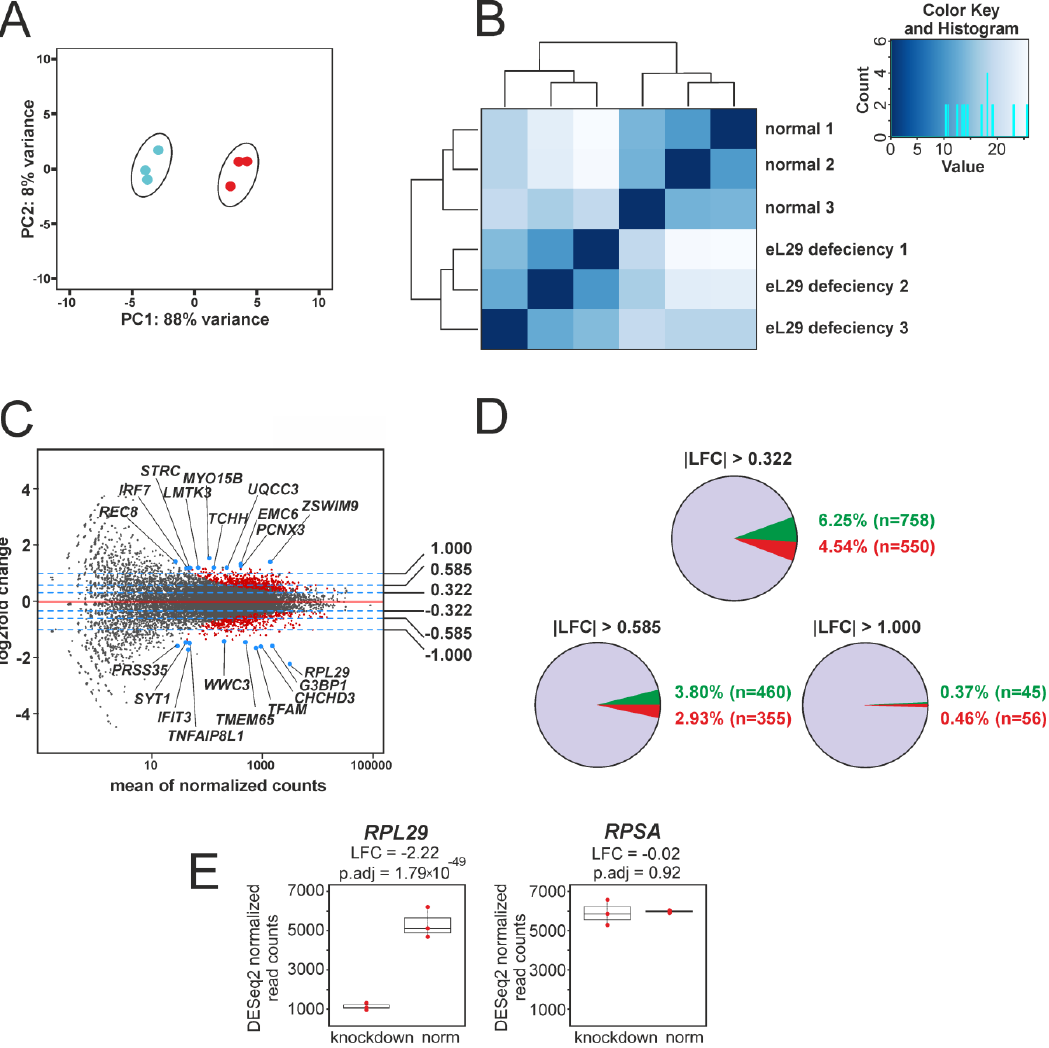
Figure 2. Summary of the results of exploratory RNA-seq data analysis. ( A ) PCA plot of gene expression data obtained via RNA-seq data for three biological replicates corresponding to the samples from HEK293 cells transfected with scrambled siRNA (blue dots) and from those knocked down of eL29 (red dots). ( B ) A heatmap based on the Euclidean distance matrix between the replicates of the above samples, designated as “normal” and “eL29 deficiency”, respectively, displaying hierarchical gene clustering for each replicate. The color key and the histogram panel show the total number of RNA-seq datasets as a function of their Euclidean distance values. ( C ) MA plot of the LFCs values of all genes, exposing the results of differential gene expression analysis with RNA-seq data